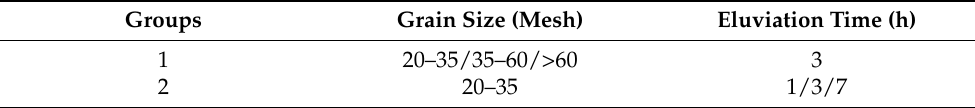
Table 2. Dynamic eluviation test scheme.